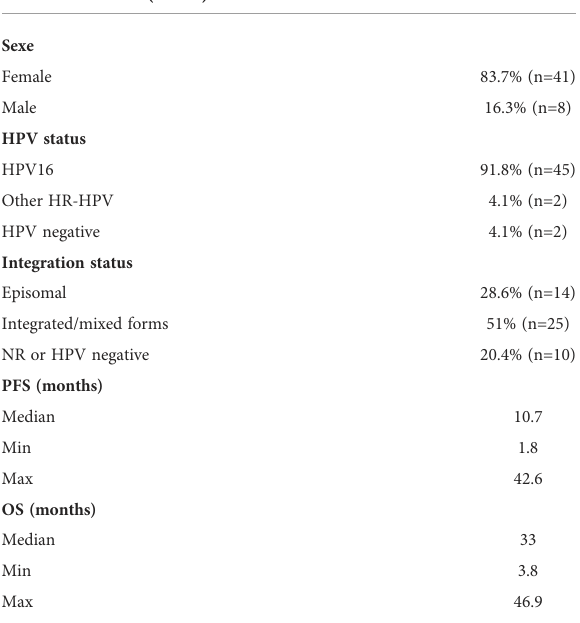
TABLE 5 Characteristics of the HPV02